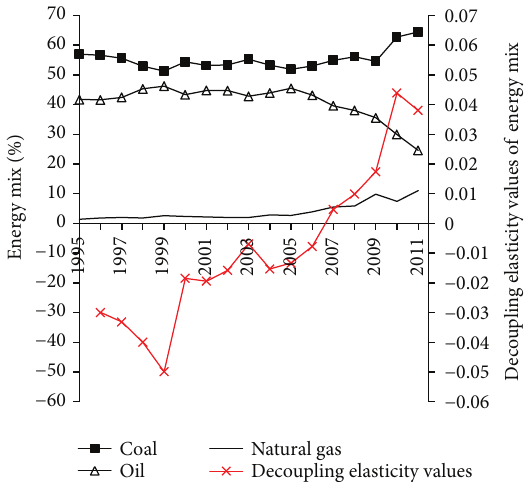
Figure 2: Change trends of energy-related carbon emission from 1995 to 2011. Figure 3: Energy mix and decoupling elasticity values of energy mix from 1995 to 2011.